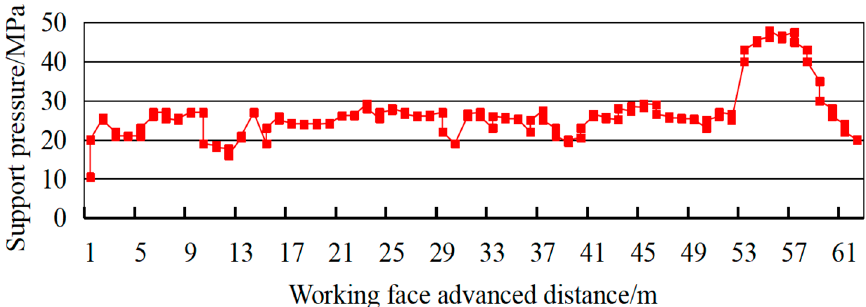
Figure 2. First weighting curve of the no. 12401 working face. Appl. Sci. 2020 , 10 , x FOR PEER REVIEW